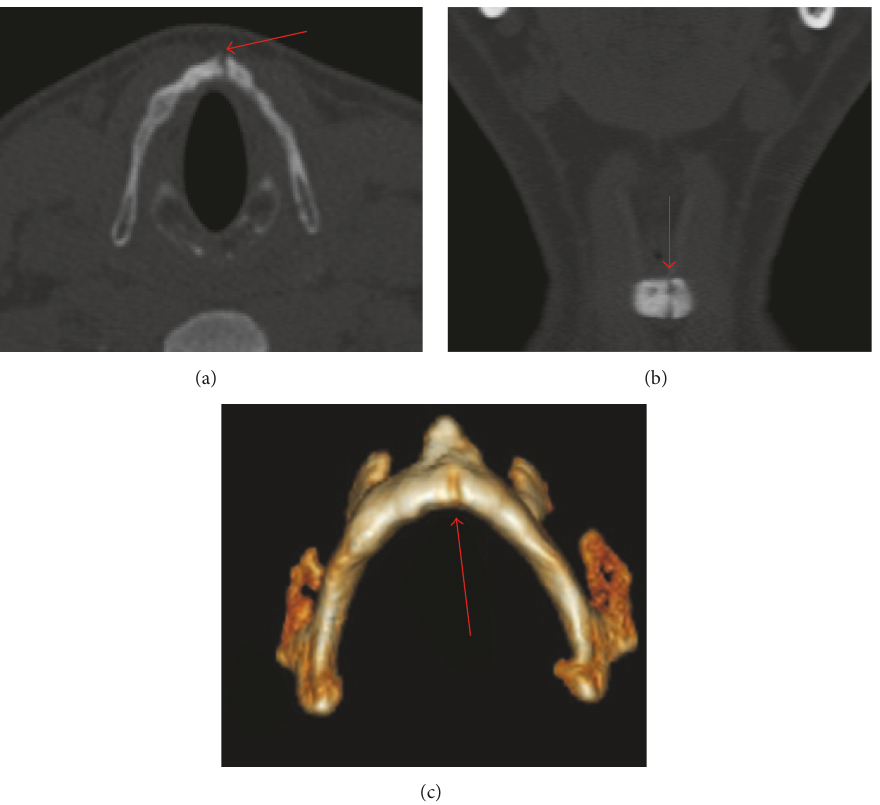
Figure 1: Computed tomography, bone window. Left, complete, and nondisplaced parasagittal fracture that compromises thyroid cartilage (red arrows). (a) Axial view; (b) coronal view; (c) 3D bone